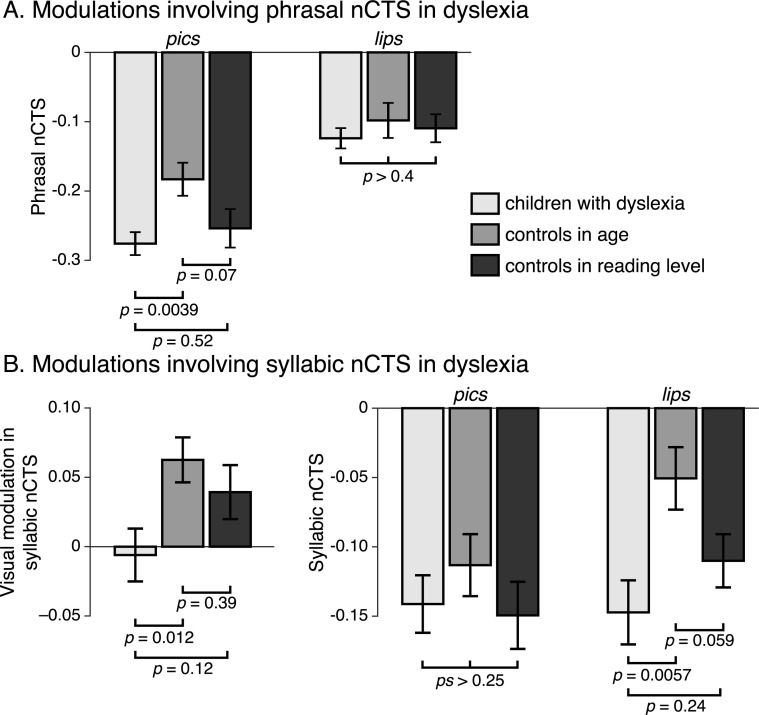
Comparison between children with dyslexia and controls in the measures of nCTS significantly related to reading abilities.(A) Modulations involving phrasal nCTS. Displayed are the mean and SEM within groups (dyslexia, control in age, and control in reading level) of phrasal nCTS in the conditions with (lips) and without (pics) visual speech information. Values of nCTS were averaged across hemispheres and babble noise conditions for phrasal nCTS and across hemispheres and all noise conditions for syllabic nCTS. (B) Modulations involving syllabic nCTS. On the left is the visual modulation in syllabic nCTS. The right part is as in (A). S4 Data contains the underlying data for this figure. nCTS, normalized cortical tracking of speech.